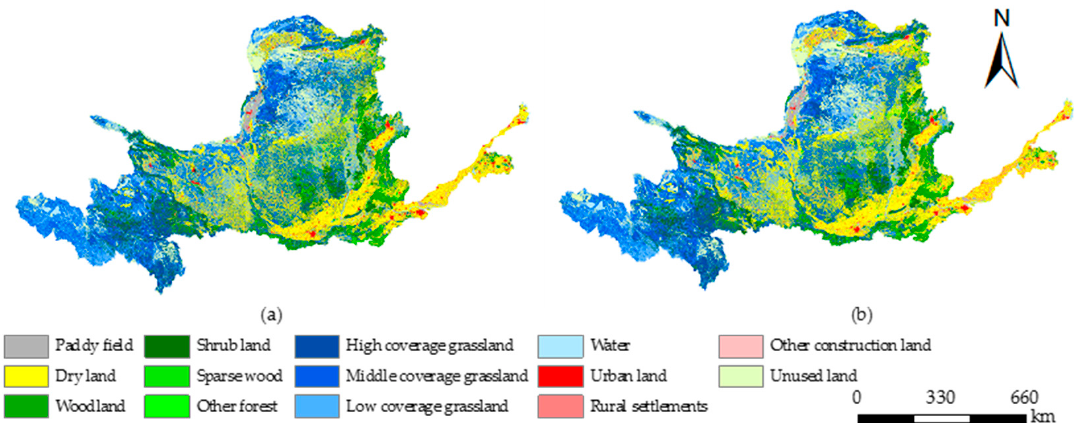
Figure 5. Current situation and simulation map of land use and cover in the Yellow River Basin in 2020: ( a ) land use map in 2020 and ( b ) simulated land use map in 2020.